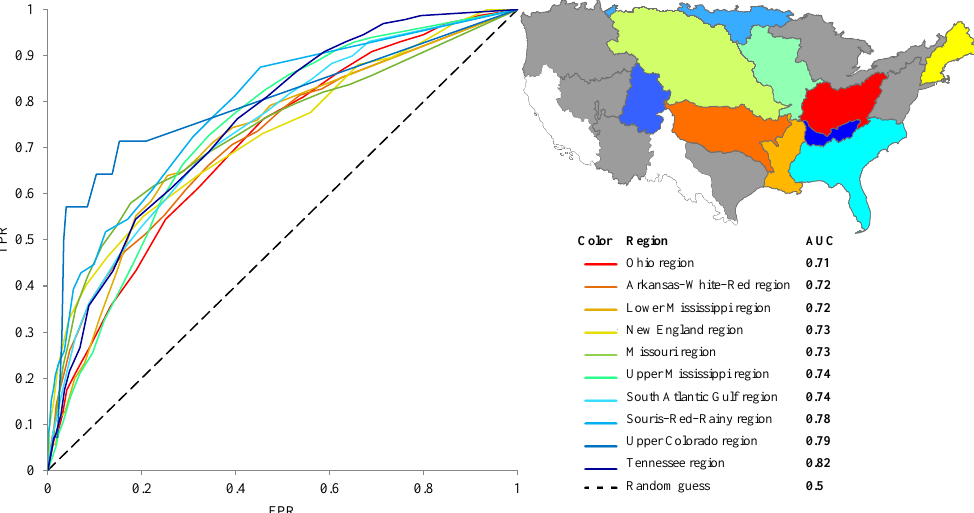
Figure 6. The RFPI predictive skills are evaluated by comparing with USGS-reported floods using ROC curves and AUC values for each of the major watersheds. The colors of the ROC curve match the colors of the delineated watersheds. The Rio Grande and California watersheds (in white) were excluded due to low number of floods. The watersheds that have RFPI AUC values less than 0.7 are in grey color (Lower Colorado, Texas Gulf, Great Basin, Great Lakes, mid-Atlantic and Pacific Northwest) and not shown in the comparison.